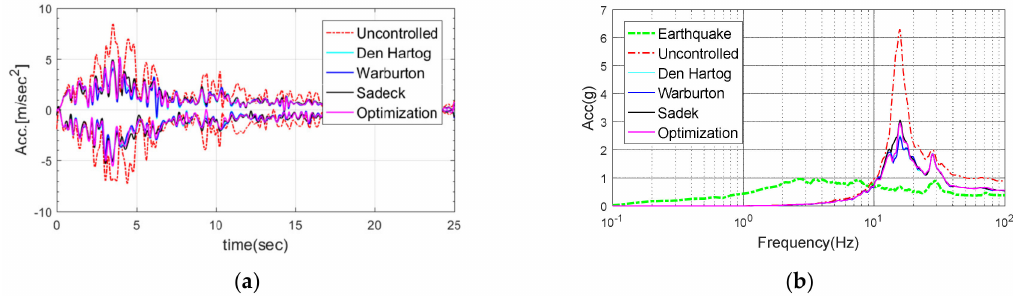
Figure 24. Response of the electrical cabinet subjected to San Fernando: ( a ) Time history; ( b ) Response spectrum.